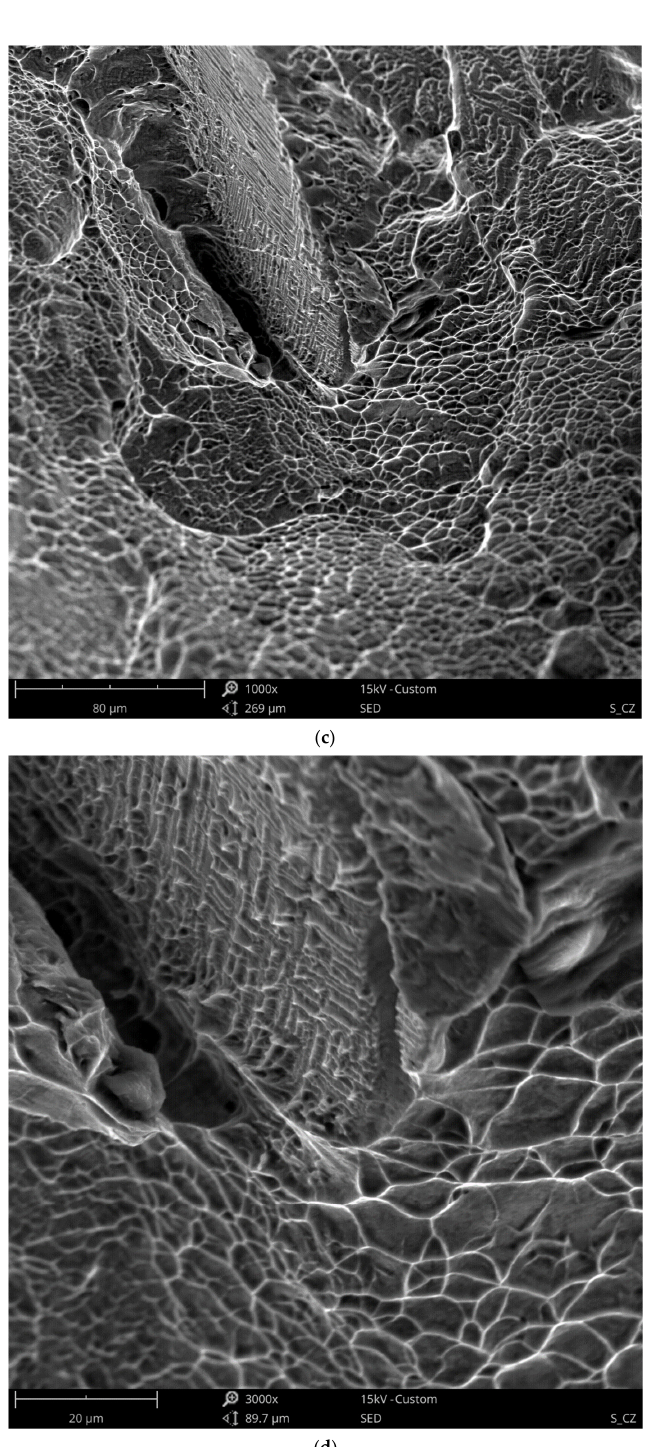
Figure 15. Fracture morphology ( a ) of the titanium weld joint after fatigue tests at 0.82 σ UTS under different magnifications; ×500 ( b ), ×1000 ( c ), ×3000 ( d ).